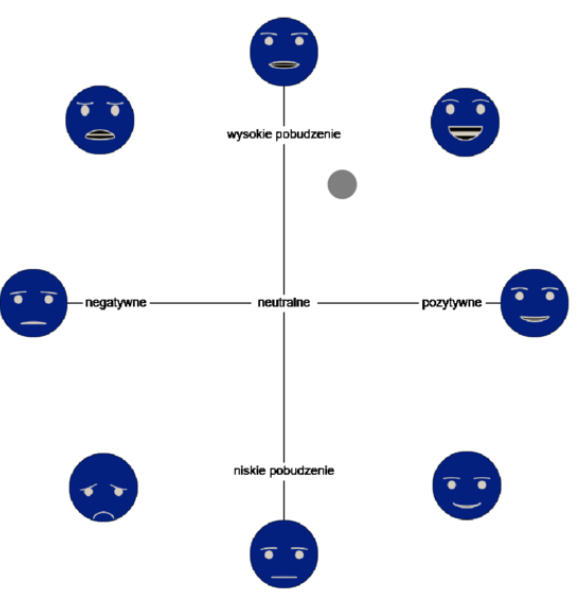
Figure 2. “Valence-arousal faces” widget as in the study (in Polish). X axis has labels “negative”, “neutral”, and “positive”, while the Y axis has labels: “high arousal” and “low arousal”. The picture is presented with a negative